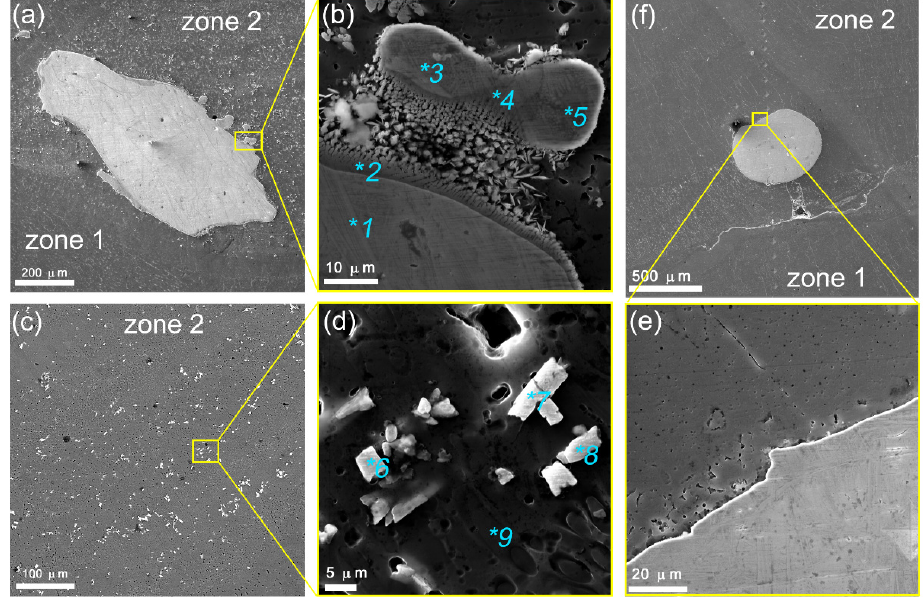
Figure 6. SEM BSE images of zone 2 AA5154/Mo coarse Mo particles ( a , c , f ),and enlarged views of IMCs formed around the coarse particles ( b , d , e ) in the 0.3 g/layer Mo sample. 1–9 denote points selected for EDS (Table 2). Table 2. EDS analysis of the AA5154/Mo with 0.3 g/layer was obtained by using SEM (Figure 6b,d). Concentration of Elements, at.% Spectrum